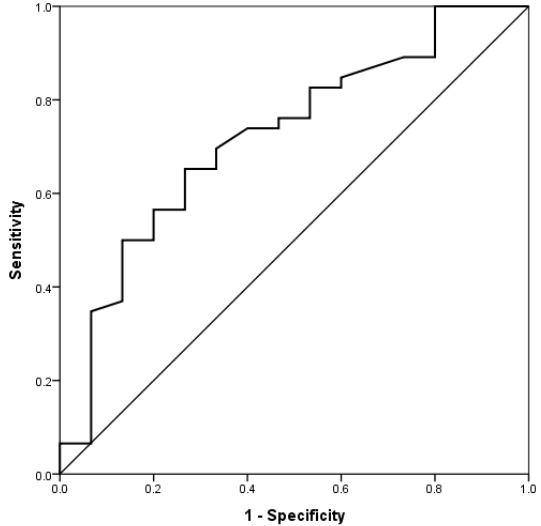
Figure 2. Receiver operating characteristic (ROC) analysis to determine the cutoff value of serum uric acid for the prediction of early allograft dysfunction. Table 4. Univariate analysis and logistic regression